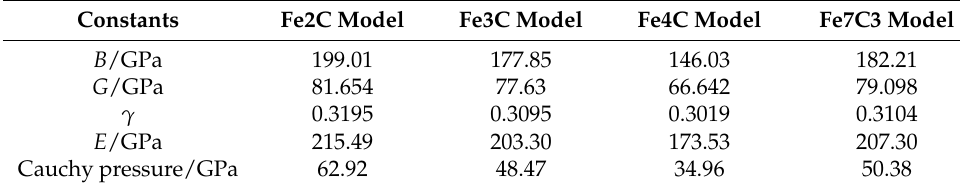
Table 5. MD-calculated elastic properties of the ferrite–carbide models.